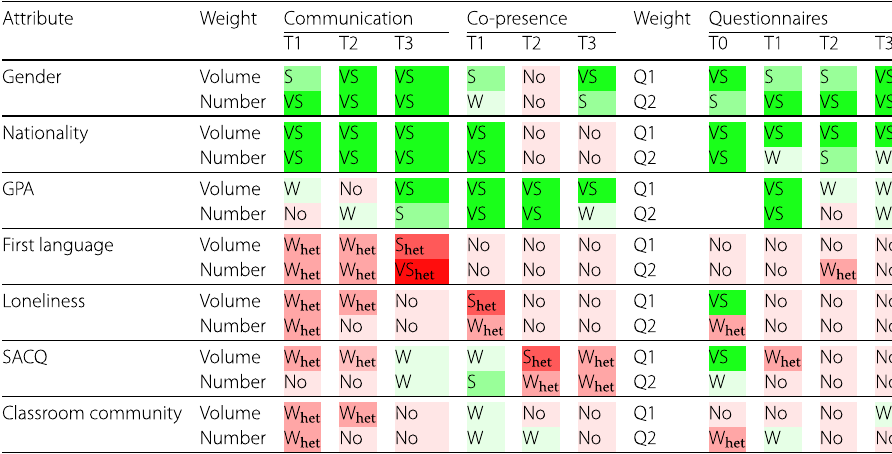
Table 4 Summary of the dyadic homophily patterns found in the different networks, with respect to the various attributes